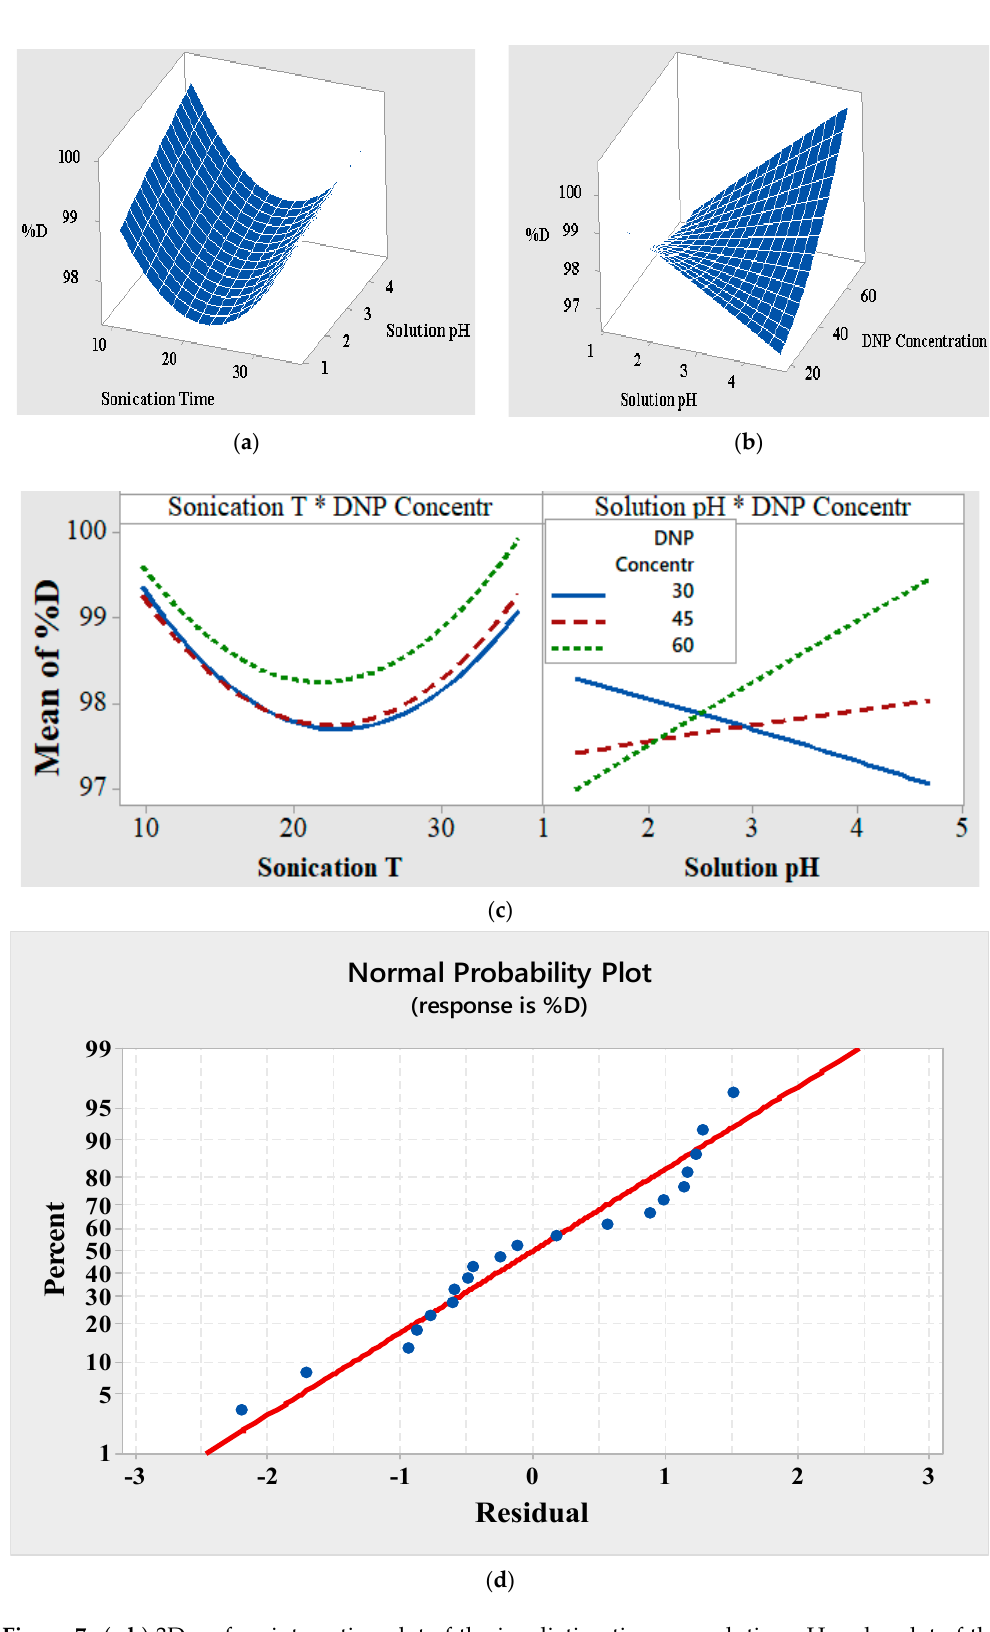
Figure 7. ( a , b ) 3D surface interactive plot of the irradiation time vs. solution pH and a plot of the solution pH vs. the DNP concentration; ( c ) interaction curves of all three reaction variables, namely irradiation time, solution pH, and DNP concentration; and ( d ) normal probability plot depicting the data points along the straight line.